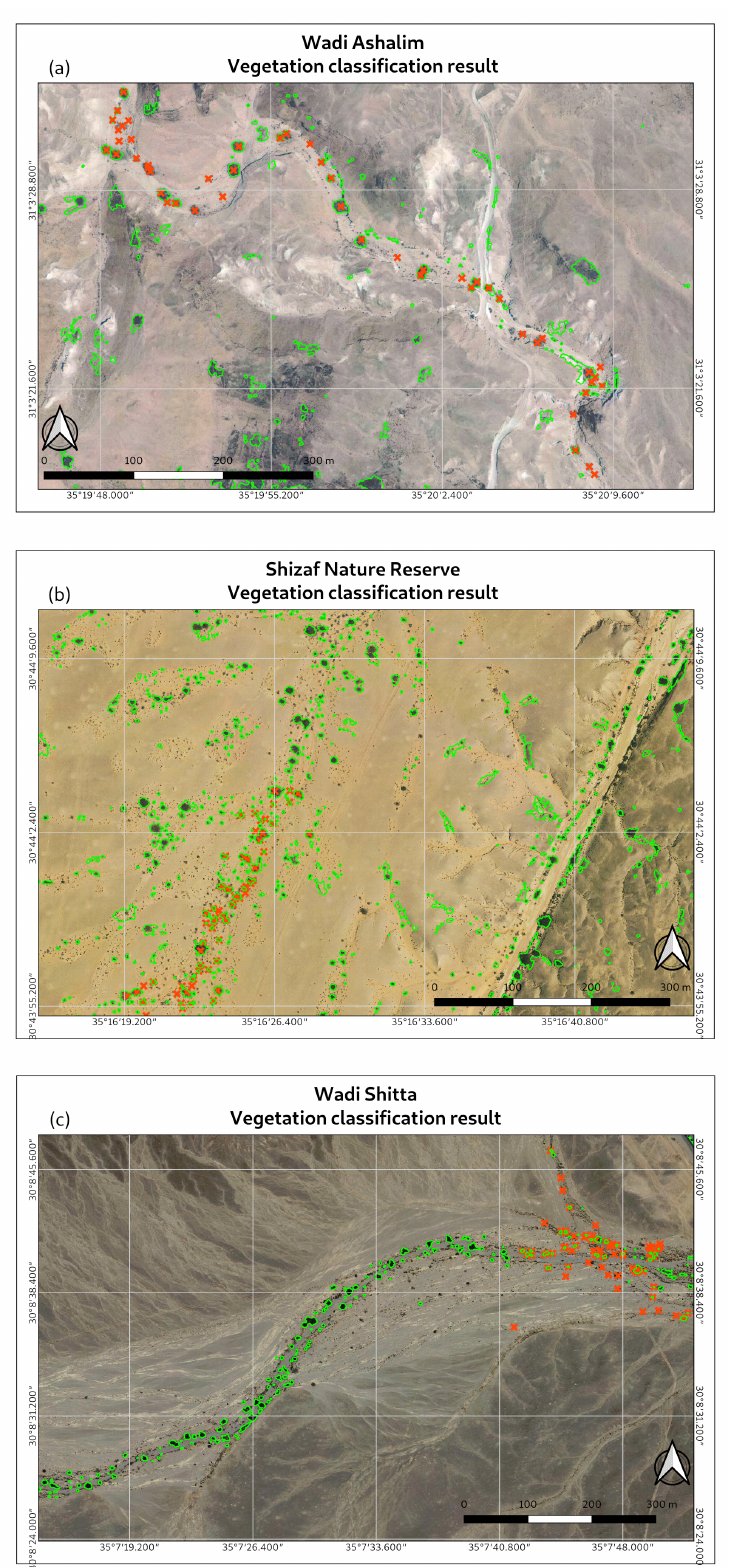
Figure 6. Three vegetation classification results. Wadi Ashalim ( a ), northern zone in Shizaf ( b ), and the eastern zone in Shitta ( c ). Monitored tree locations appear as red crosses, and vegetation patches are outlined in